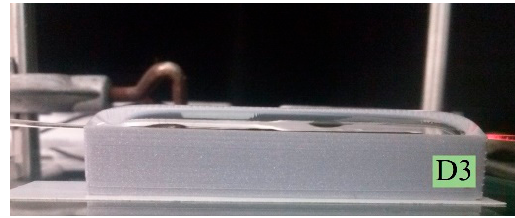
Figure 4. D-shaped POF sensor with the sensing region covered by water.